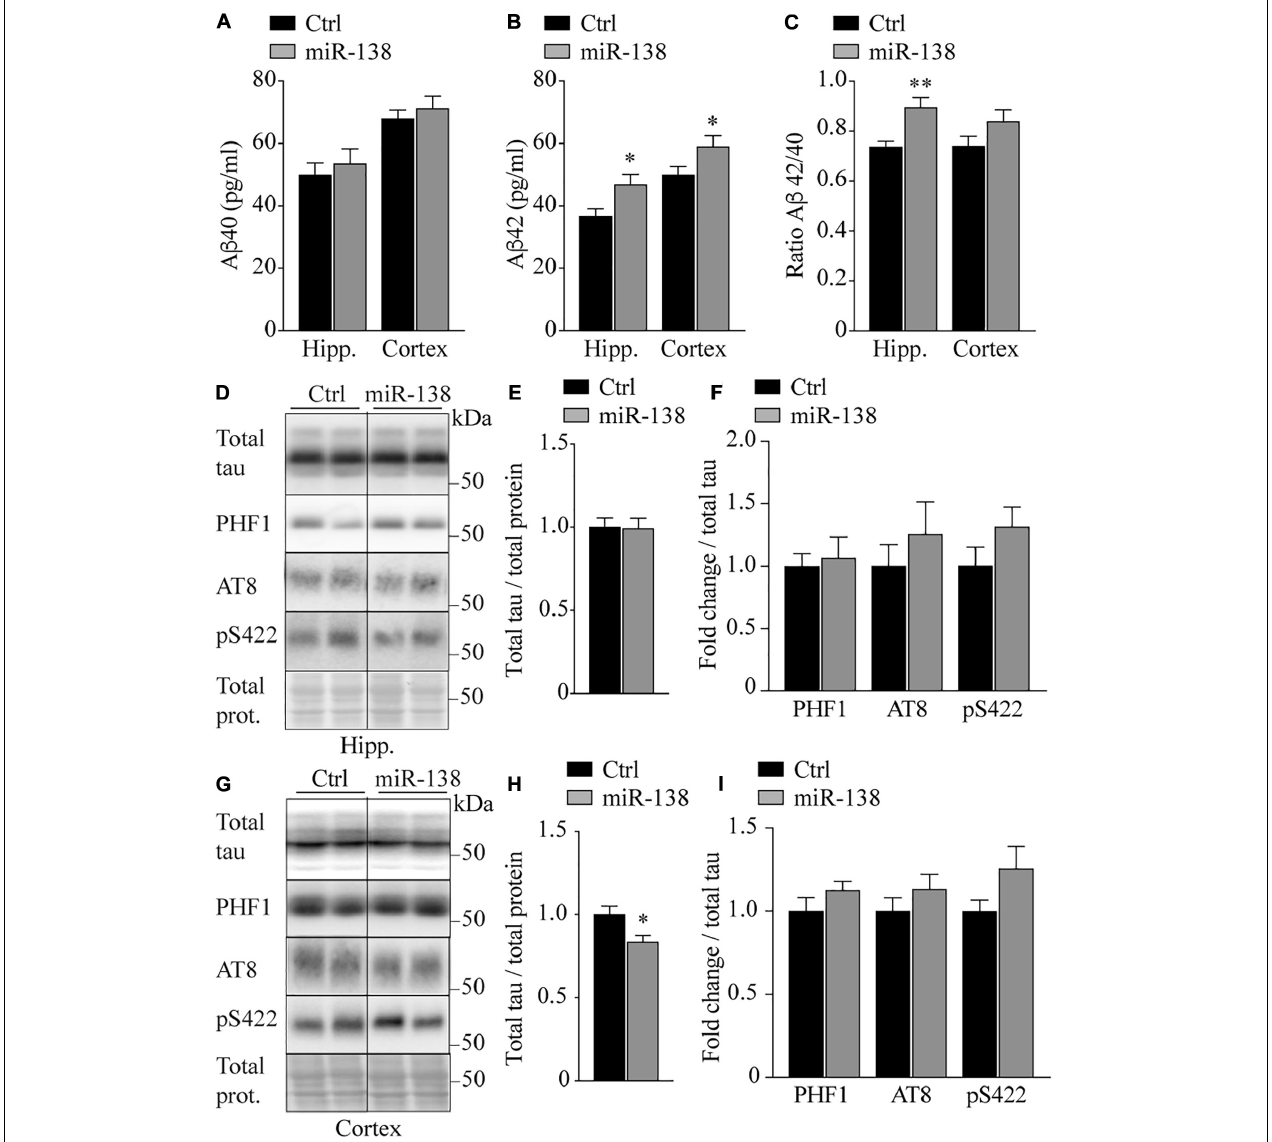
FIGURE 3 | Increase of A β 42 and decrease of total tau in miR-138 mice. ELISA of (A) endogenous murine A β 40, (B) A β 42, and (C) A β 42/40 ratio from hippocampus (Hipp.) and frontal cortex (Cortex), in miR-138 mice ( n = 11, sex mixed) compared to Ctrl mice ( n = 13, sex mixed), 4 months after injection. (D) Representative Western blot of endogenous (E) total Tau and (F) PHF1, AT8, and pS422 quantifications in hippocampus (Hipp.). (G) Representative Western blot of endogenous (H) total Tau and (I) PHF1, AT8, and pS422 quantifications in frontal cortex (Cortex). Total tau bands were normalized to total proteins and phospho-tau bands were normalized to total tau. All analyses were performed on 30 mice in total ( n = 13 males and n = 17 females). Data are presented as ± SEM: * P < 0.05 (unpaired student t